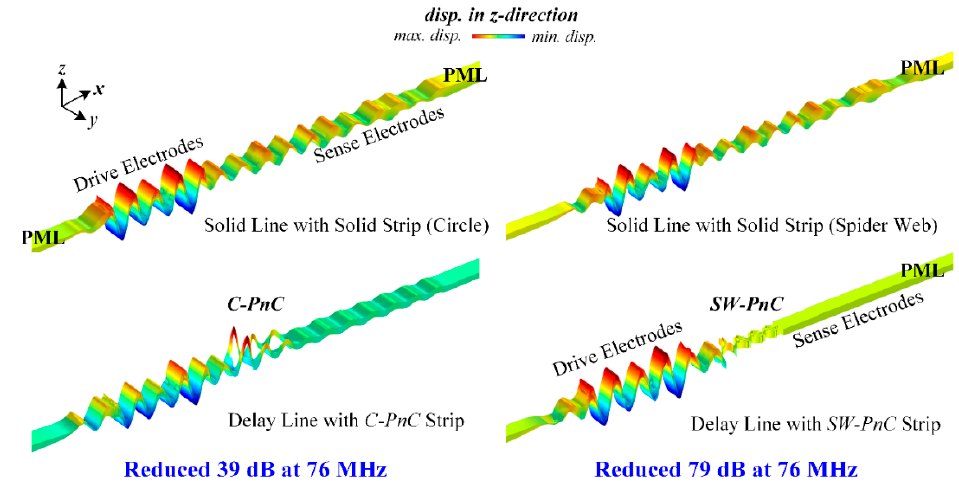
Figure 5. Illustration of the displacement distribution in the z-direction of two types of delay line and solid line working in the frequency of 76 MHz, and a more significant isolation of the acoustic wave in the delay line where a smaller-sized SW-PnC strip is observed. In general, due to the large circle hole, the C-PnC is already a very lightweight PnC structure compared with previously reported PnCs. Nevertheless, the proposed SW-PnC possesses a smaller lattice constant (70.6%), much lighter weight (44.2%), and greater energy loss suppression (two-fold) in a similar bandgap frequency range compared with C-PnC .